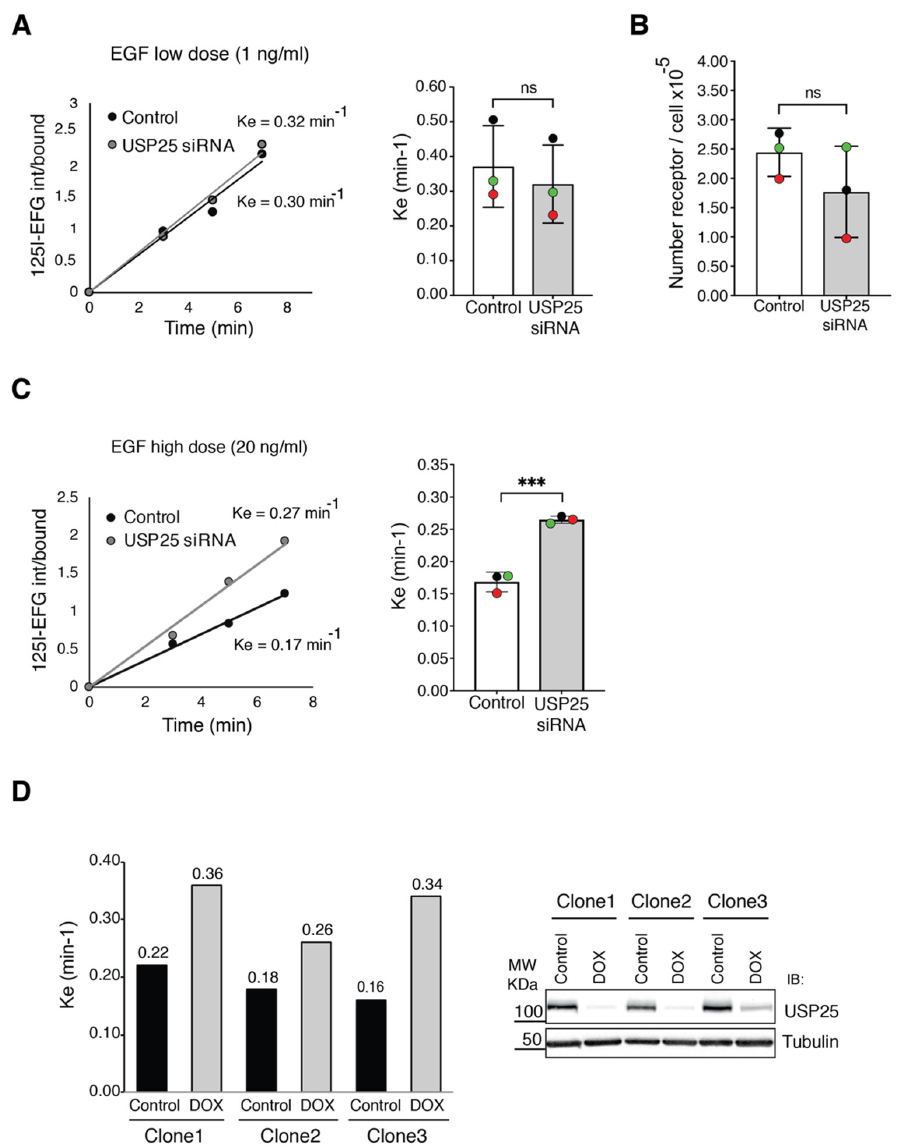
Figure 3. EGFR internalization is enhanced upon USP25 depletion. ( A , C ) Assessment of EGFR internalization in HeLa cells transiently transfected with a RNAi oligo targeting USP25 or a scramble oligo (control). Serum-starved cells were stimulated with low-dose (1 ng / mL) ( A ) or high-dose (20 ng / mL) radiolabeled EGF ( 125 I-EGF) ( C ) as indicated. Results are expressed as the ratio between internalized and bound ligand. A representative internalization curve is shown (left panels). The Ke is the average of three independent experiments (each replicate is represented by a di ff erent color) ± SD. ns, not significant; *** p < 0.001 (right panel). ( B ) Saturation binding assay using 125 I-EGF to determine the number of EGFR molecules on the cell surface. Results are an average of three independent experiments (each replicate is represented by a di ff erent color). ( D ) Left panel: assessment of EGFR internalization (at early timepoints, 0 and 7 min) in three di ff erent USP25 shRNA inducible clones. USP25 depletion was induced with doxycycline treatment (0.5 µ g / mL). Right panel: validation of USP25 depletion by IB analysis of total cell lysates as